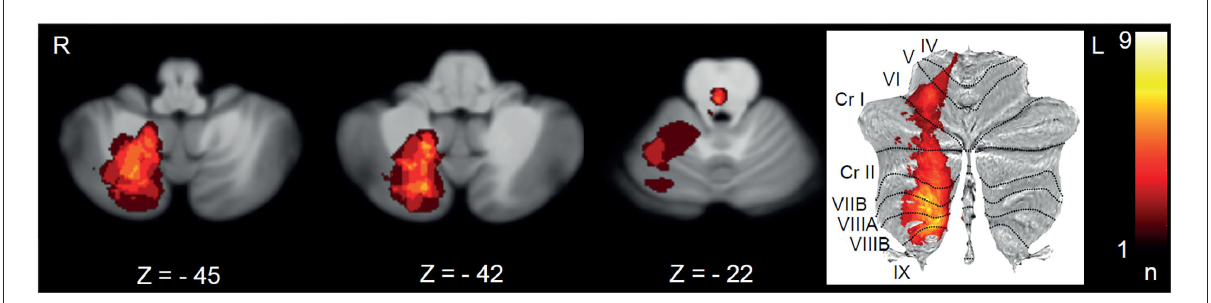
FIGURE1 Lesion mapping of all strokes with the chief complaint of vertigo, dizziness, or double vision depicted on transverse sections ( Z -scores in MNI space) and as a surface plot. L, left; R, right.